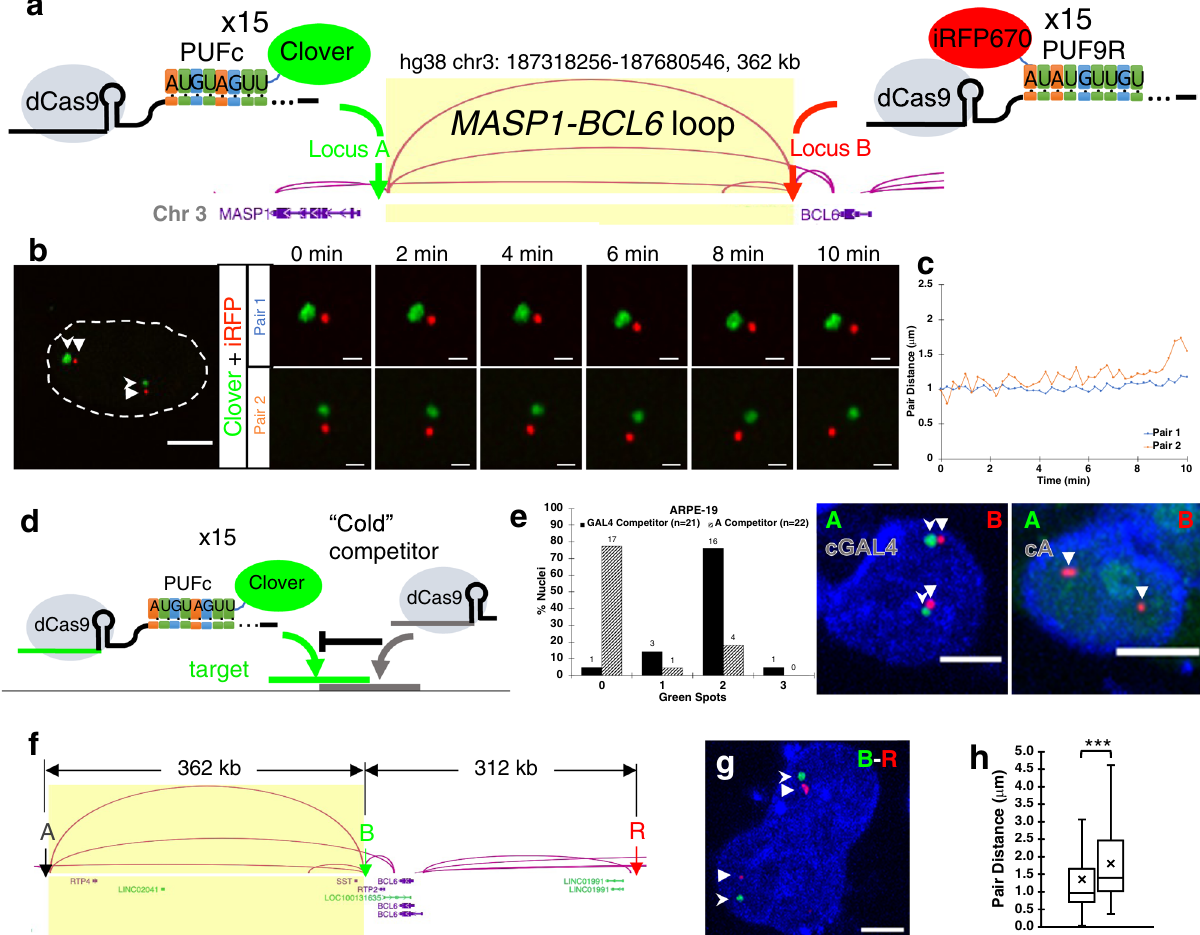
Fig. 3 Casilio live-cell imaging of chromatin interactions and validation. a Casilio probes for visualizing chromatin interactions mediated by cohesin. Locus A (5 ’ anchor) labeled by gRNA-15xPBSc/Clover-PUFc and locus B (3 ’ anchor) labeled by gRNA-15xPBS9R/PUF9R-iRFP670. MASP1-BCL6 loop with anchors 367 kb apart. Arc height is proportional to number of ChIA-PET sequencing reads. b Representative time-lapse images of MASP1-BCL6 loop anchors, locus A near MASP1 (Clover, green, stealth arrowhead) and locus B near BCL6 (iRFP670, red, triangle arrowhead), in ARPE-19 cells. Image strips show two allelic pairs at indicated time points. Whole nucleus (outlined) at time zero is shown on left. See Supplementary Video 1. Whole nucleus scale bar, 5 μ m. Time-lapse scale bars, 1 μ m. Experiment repeated 8 times. c Pairwise 3D distances of fl uorescent foci in b over time. See Supplementary Fig. 1 for all distance plots of imaged nuclei ( n = 20 nuclei; 33 pairs). d Schematic of competitor experiment. “ Cold ” competitor gRNA without Pumilio binding sites (PBS) for fl uorescent protein recruitment binds to sequence overlapping test target. e Competitor experiments for validating MASP1-BCL6 . Column plot shows percentages of nuclei with indicated numbers of Clover (green) spots (nucleus counts on top of columns) in ARPE-19 cells co-transfected with Clover-PUFc/A-15xPBSc, PUF9R-iRFP670/B-15xBPS9R and either a non-competing GAL4 gRNA (black columns) or a gRNA competing with corresponding A locus of the loop (patterned columns). Representative images in non-competed or locus A-competed samples (Clover, green, stealth arrowheads; iRFP670, red, triangle arrowheads). Scale bars, 5 μ m. Experiment repeated 3 times. f Imaging of downstream region B – R equidistant and adjacent to MASP1-BCL6 loop (A – B) with locus R at 312 kb 3 ’ of locus B. Arc height is proportional to number of ChIA-PET sequencing reads. g Representative image of co-labeling of locus B (Clover, green, stealth arrowheads) and locus R (iRFP670, red, triangle arrowheads) in ARPE-19 cells ( n = 10 nuclei; 14 pairs). Scale bar, 5 μ m. Experiment repeated 3 times. h Boxplot showing pairwise 3D distances of A – B pair ( n = 2347 measurements; mean = 1.36 μ m; median = 0.97 μ m) and B – R pair ( n = 666 measurements; mean = 1.81 μ m; median = 1.40 μ m) over time. Boxplot displays median line, mean x-marked, interquartile range boxes, and min to max whiskers. ***Mann – Whitney test two-sided p = 6.01 × 10 − 29 < 0.00001. Source data are provided as a Source Data fi